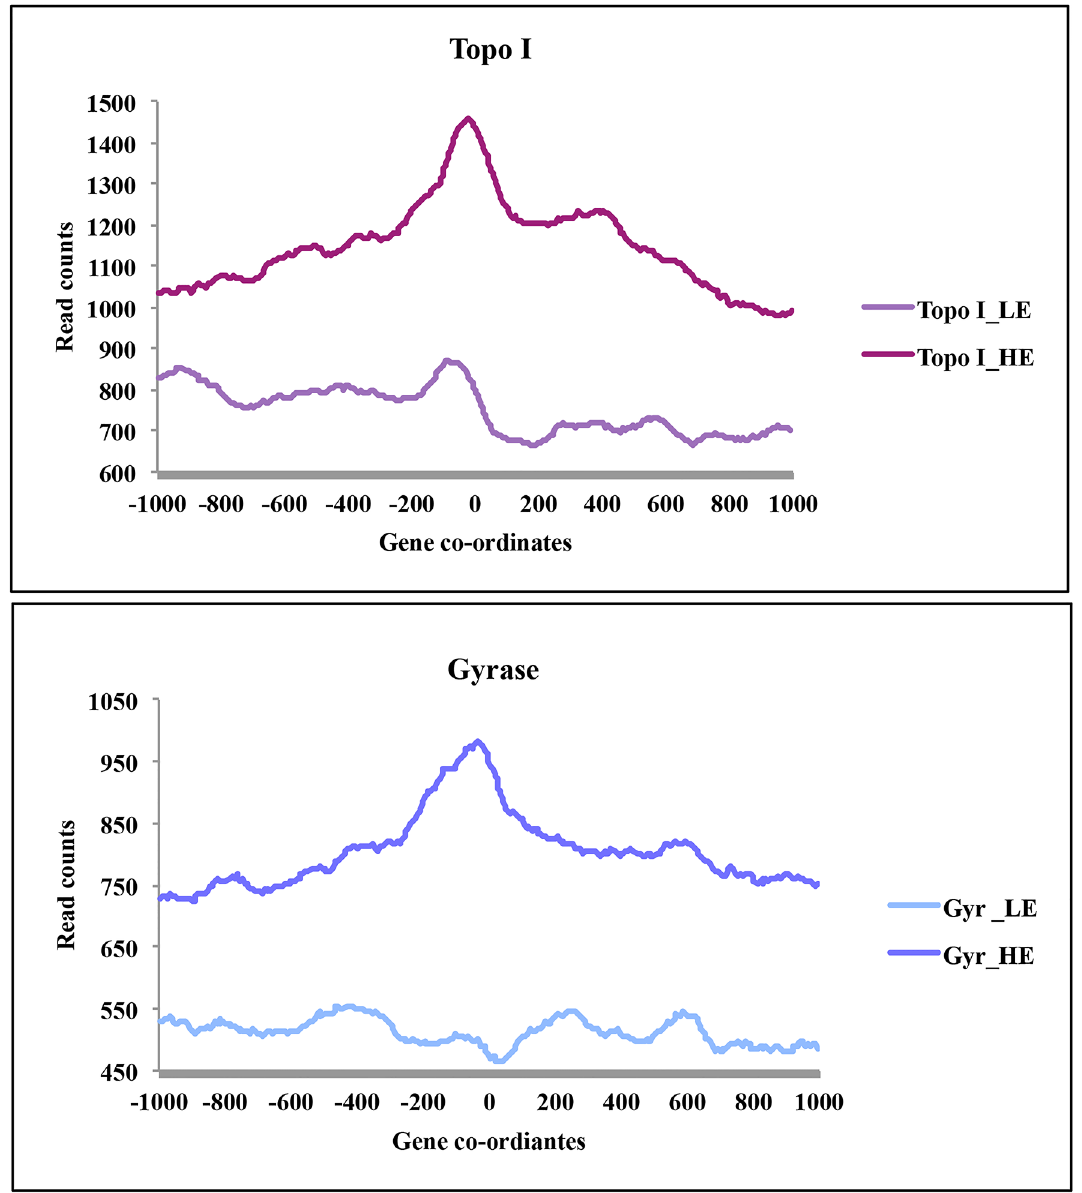
Fig 3. Topoisomerase occupancy varies on genes with different expressionlevels. The geneswere segregated based on the available RNA-Seqdata [22] under highly expressed (HE) and lowly expressed(LE) category (N = 342). The HE and LE class of gene co-ordinates were analyzedfor the occupancyof topoisomerases. TSS (0) was taken as a reference point and mean read count was plotted aroundit to generateoccupancyprofile. Mean read counts corresponding to gene co- ordinateswere plotted at a single